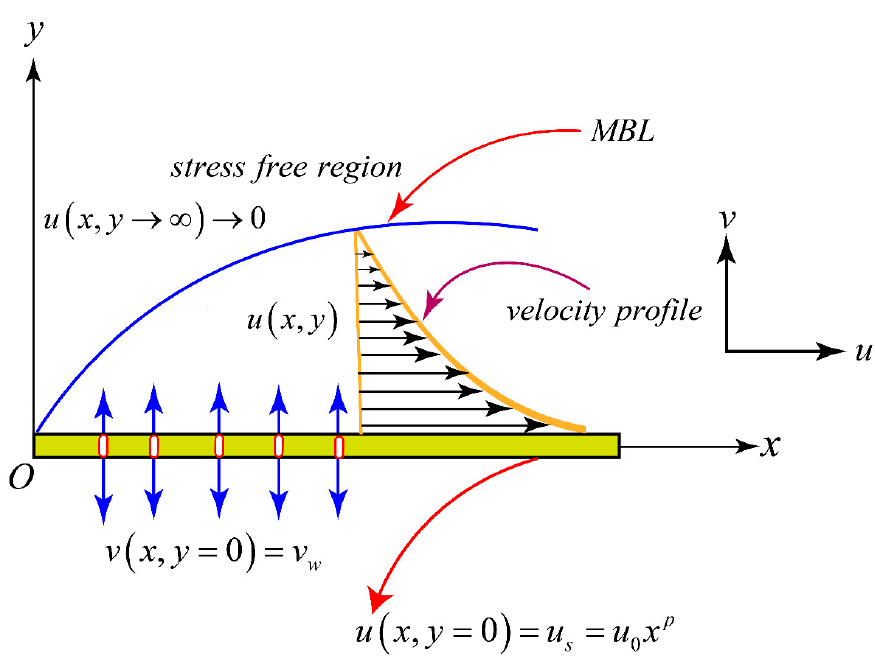
Figure 1. Flow configuration with a coordinate system.